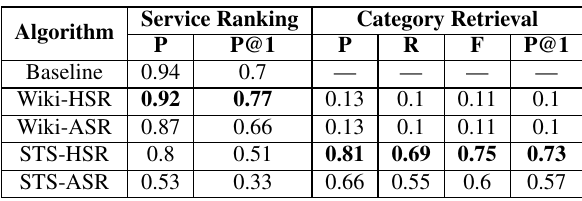
Table 3: Analysis of P and P@1 for service ranking of user generated baseline and algorithms and Summary of P, R, F